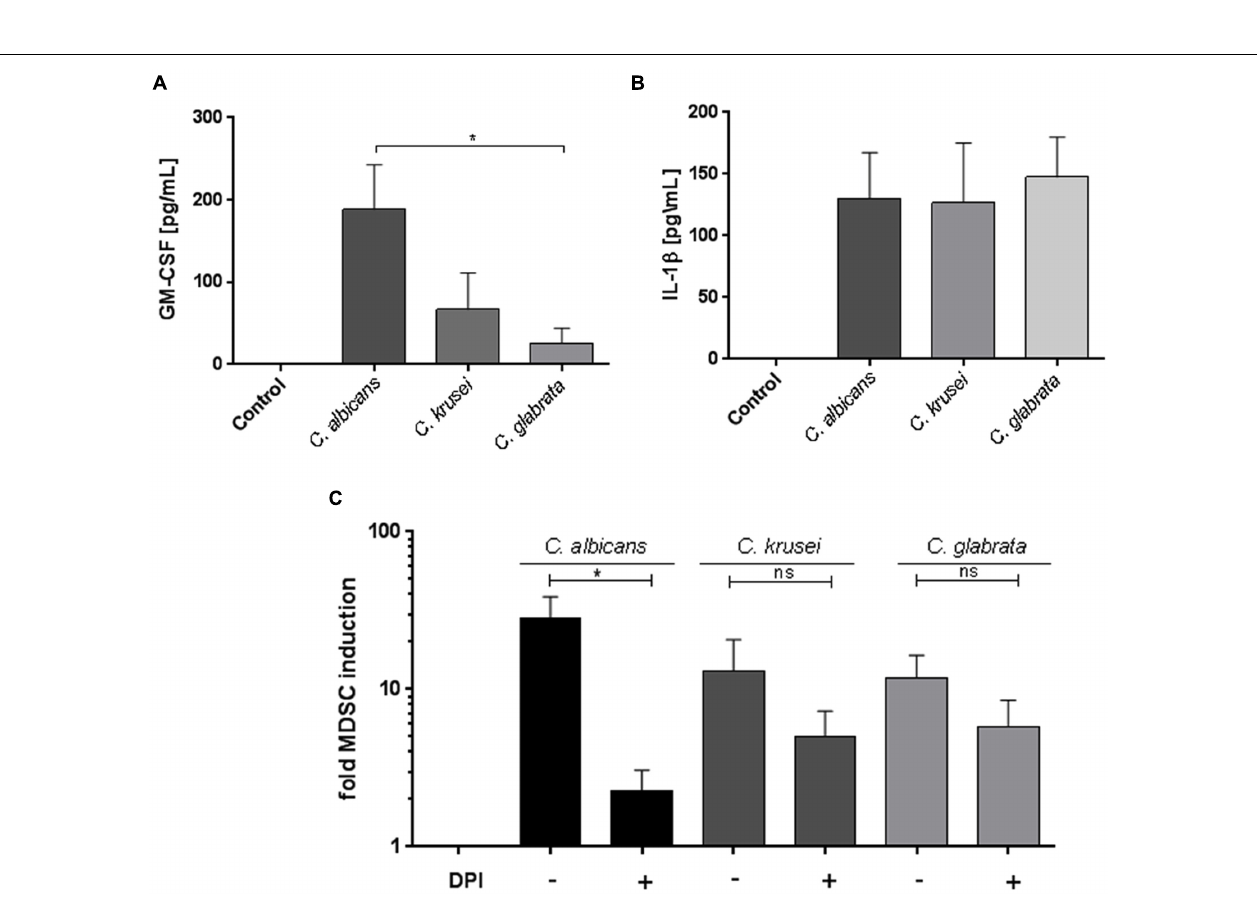
FIGURE 4 | Candida -mediated MDSC generation involves GM-CSF, IL-1 β , and ROS. GM-CSF, IL-1 β , and ROS are involved in Candida -mediated MDSC generation. Freshly isolated PBMCs (5 × 10 5 cells/ml) were cultured in medium only, or with heat killed yeast cells of C. albicans (1 × 10 5 /ml), C. krusei (1 × 10 5 cells/ml), and C. glabrata (1 × 10 5 cells/ml) for 4 days. For quantification of cytokines, co-culture supernatants were collected on day 4. (A) GM-CSF ( n = 8) and (B) IL-1 β ( n = 6) levels were quantified by ELISA. (C) MDSCs were generated in vitro by incubating isolated PBMCs (5 × 10 5 cells/ml) with with heat killed yeast cells of C. albicans (1 × 10 5 /ml), C. krusei (1 × 10 5 cells/ml), and C. glabrata (1 × 10 5 cells/ml) for 6 days. Prior to stimulation, PBMCs were pretreated for 60 min where indicated with the NADPH oxidase inhibitor DPI (0.1 µ M; n = 6) ( ∗ P < 0.05, Bars represent SEM).